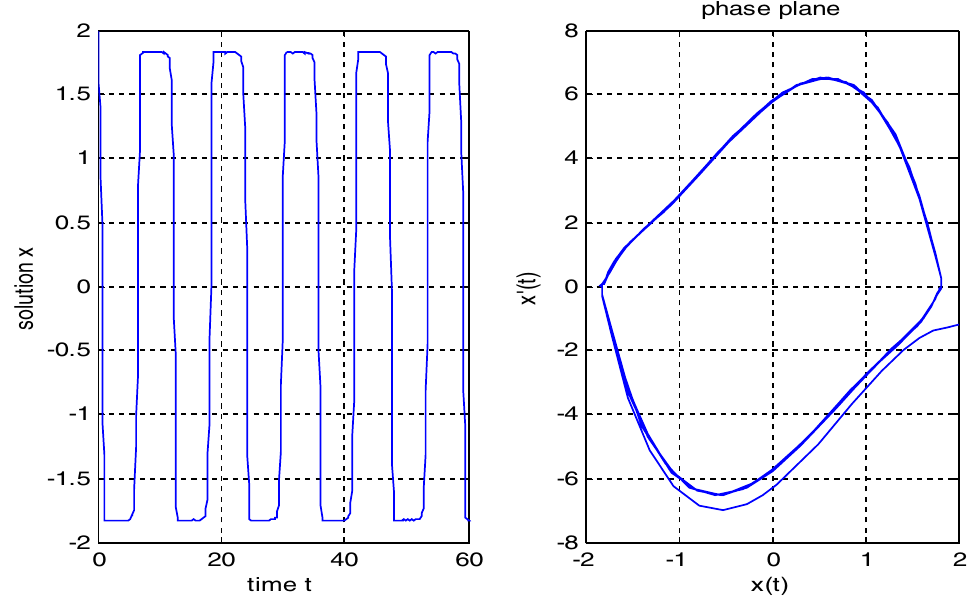
( x(t) ) 2 ( b 2 x(t τ 2 ) − −